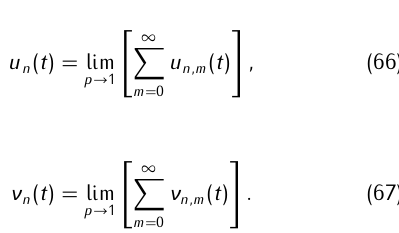
obtained in similar way, where m ∈ N